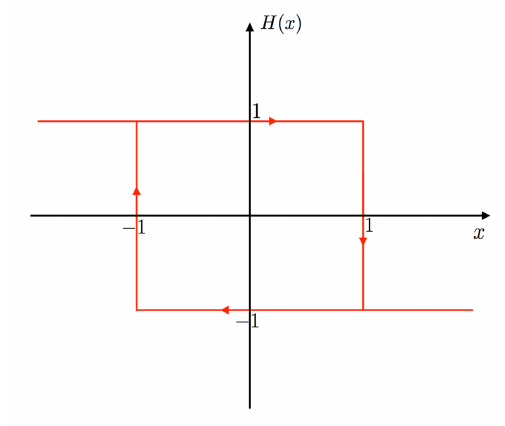
Fig. 2 The ‘graph’ of a normalized hysteresis function. The hysteresis value H ( x ) is unambiguous for x < − 1 and x > 1. However, for − 1 (cid:54) x (cid:54) 1 the output depends on the past, as explained in the